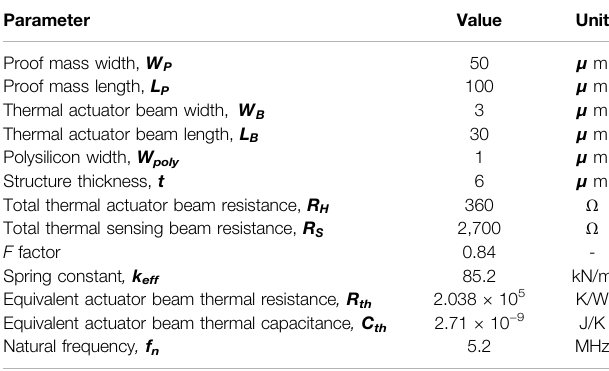
TABLE 1 | Critical dimensions of II-bar and calculated values for crucial thermal and mechanical system